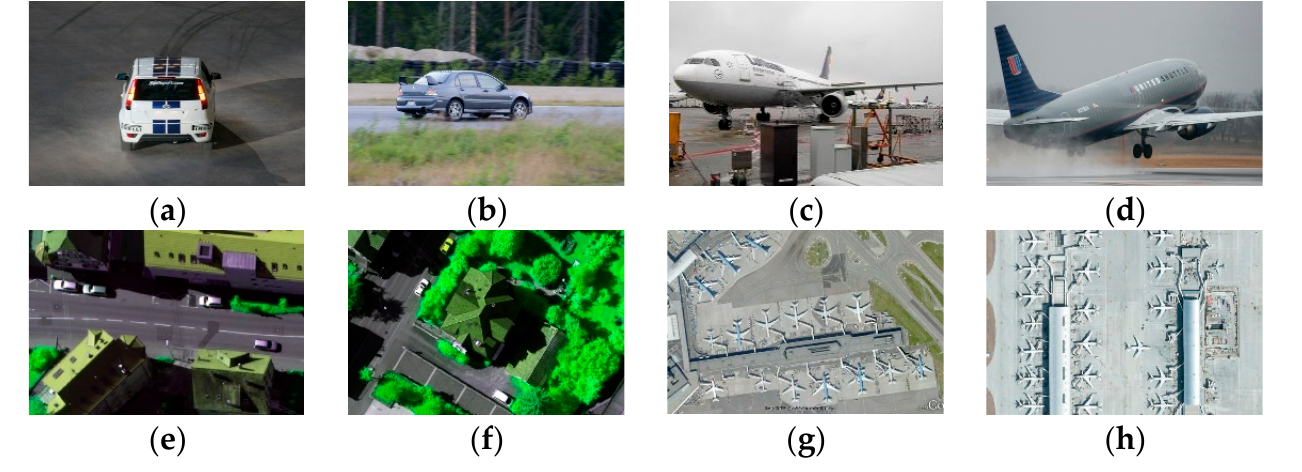
Figure 1. Visual differences between common optical images and optical remote sensing images. The first row is natural images, where the targets in ( a , b ) are vehicles and the targets in ( c , d ) are aircrafts. The second row is optical remote sensing images, where the targets in ( e , f ) are vehicles and the targets in ( g , h ) are aircrafts.